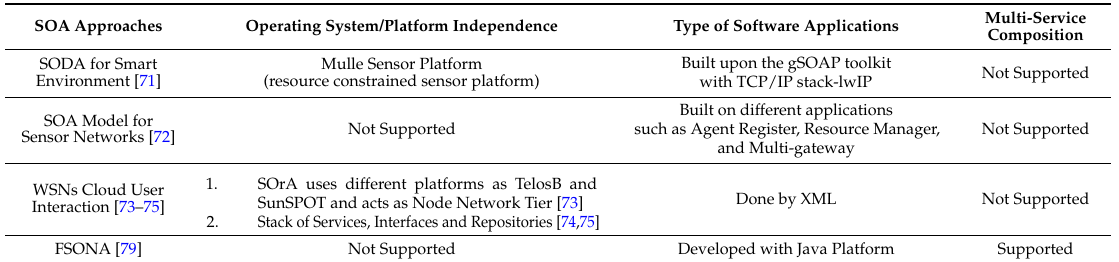
Table 5. Comparative Analysis of Service-Oriented Architectures for